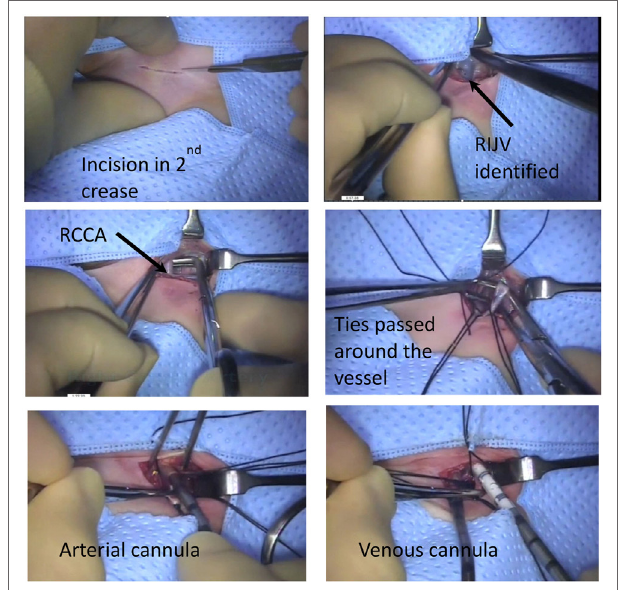
FigURe 1 | Neonatal veno-arterial cannulation